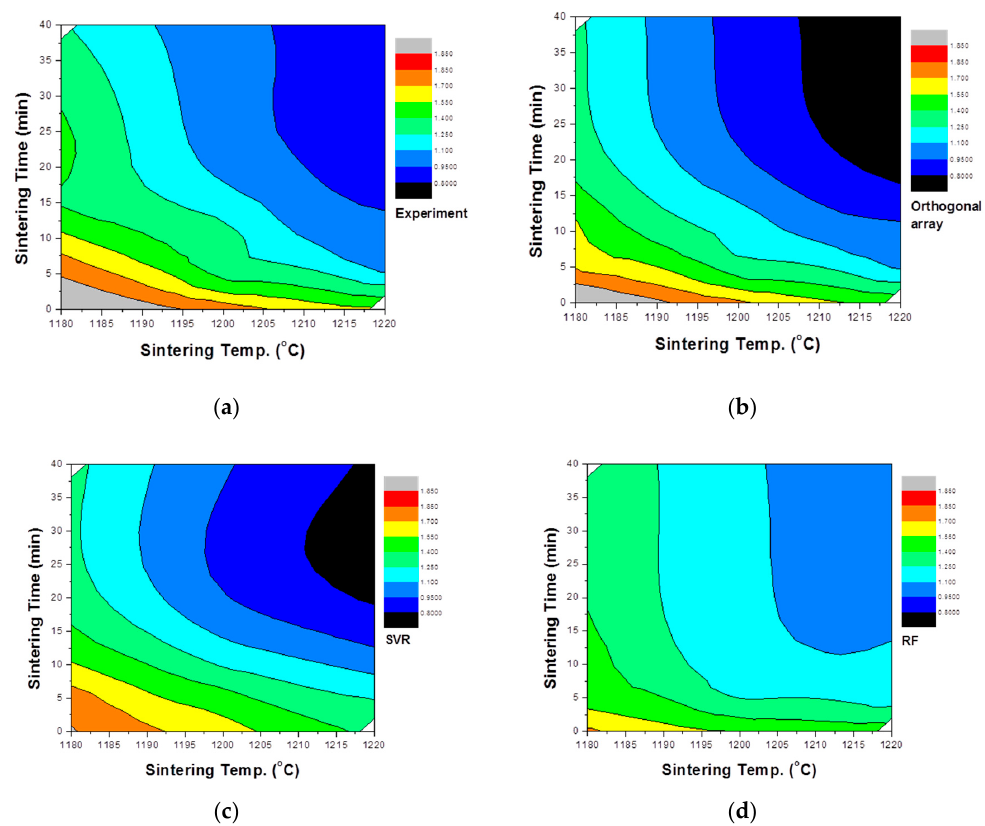
Figure 6. Particle density change of the aggregate with the soaking temperature and time as variables: ( a ) actual measurement, ( b ) orthogonal array-designed prediction, ( c ) SVR prediction, and ( d ) random forest prediction.